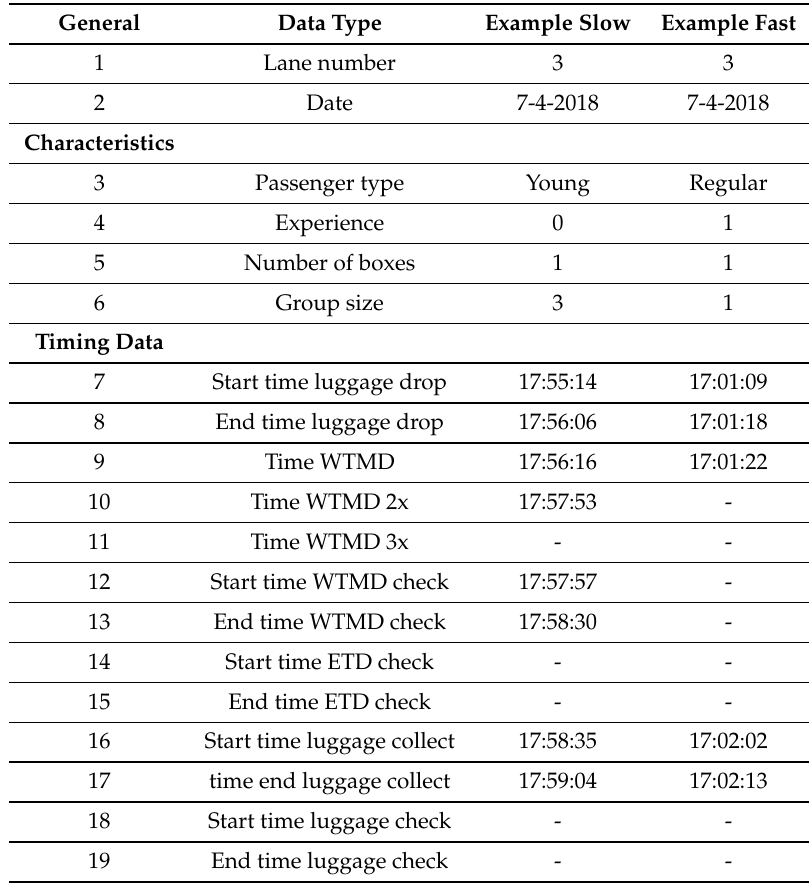
Table 2. The data that was gathered for each passenger in the dataset, along with example data of a slow and a fast